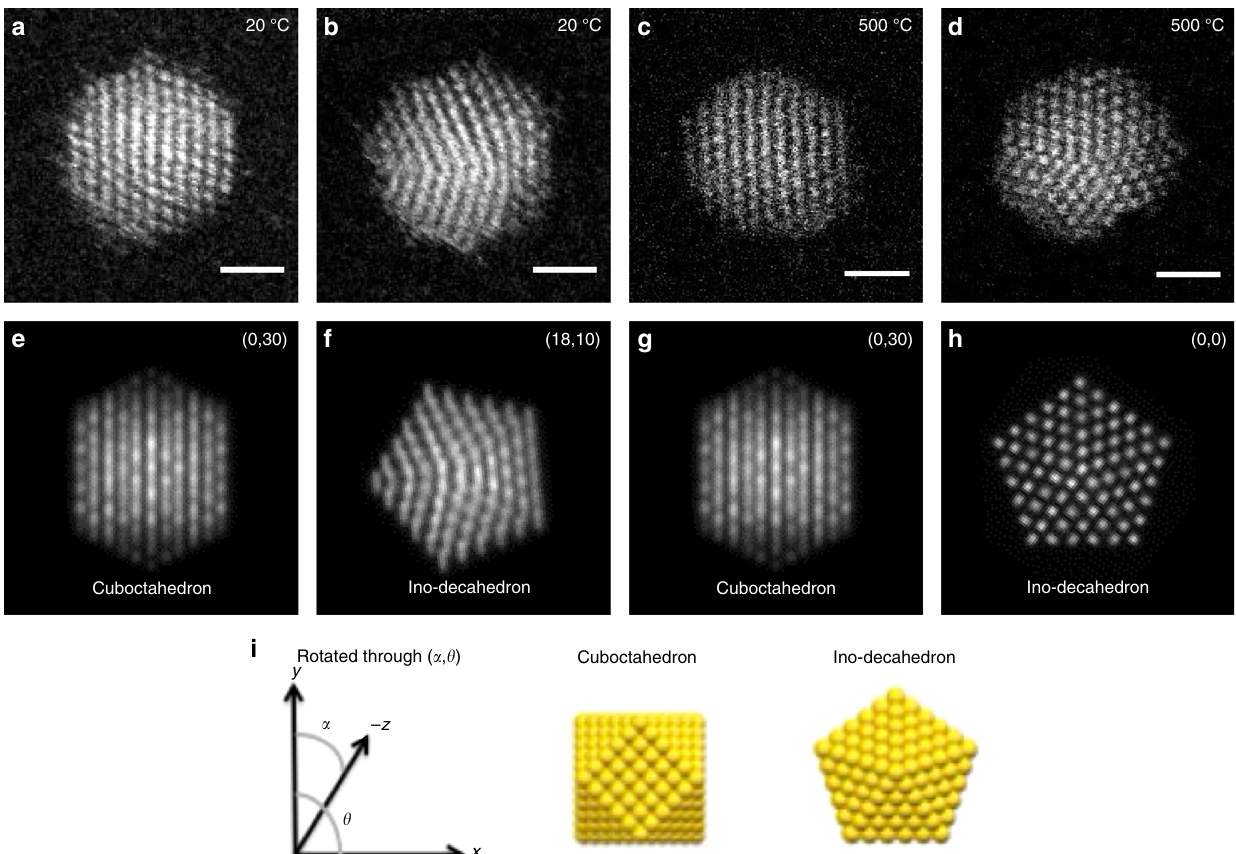
Fig. 1 HAADF STEM images of Au 561 clusters at 20 °C and 500 °C. a – d HAADF STEM images of Au 561 clusters and e – h matching multi-slice electron scattering simulations of the cuboctahedron and Ino-decahedron at different orientations. a , b Experimental images recorded at 20 °C; c , d Images recorded at 500 °C. i Rotation angle of the cuboctahedron and Ino-decahedron